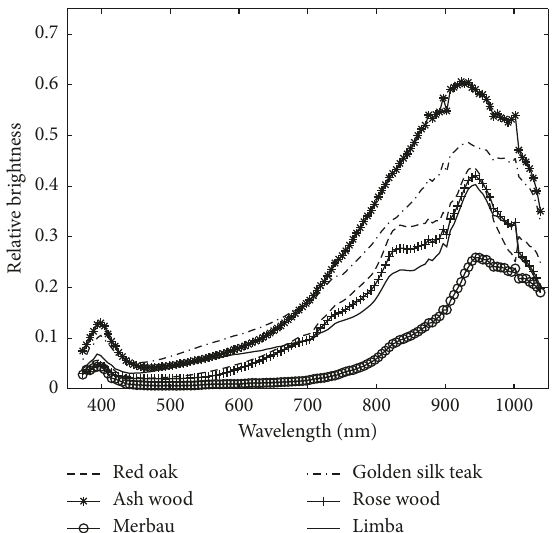
Figure 6: Spectral difference in wood vessels’ central region for six hardwood